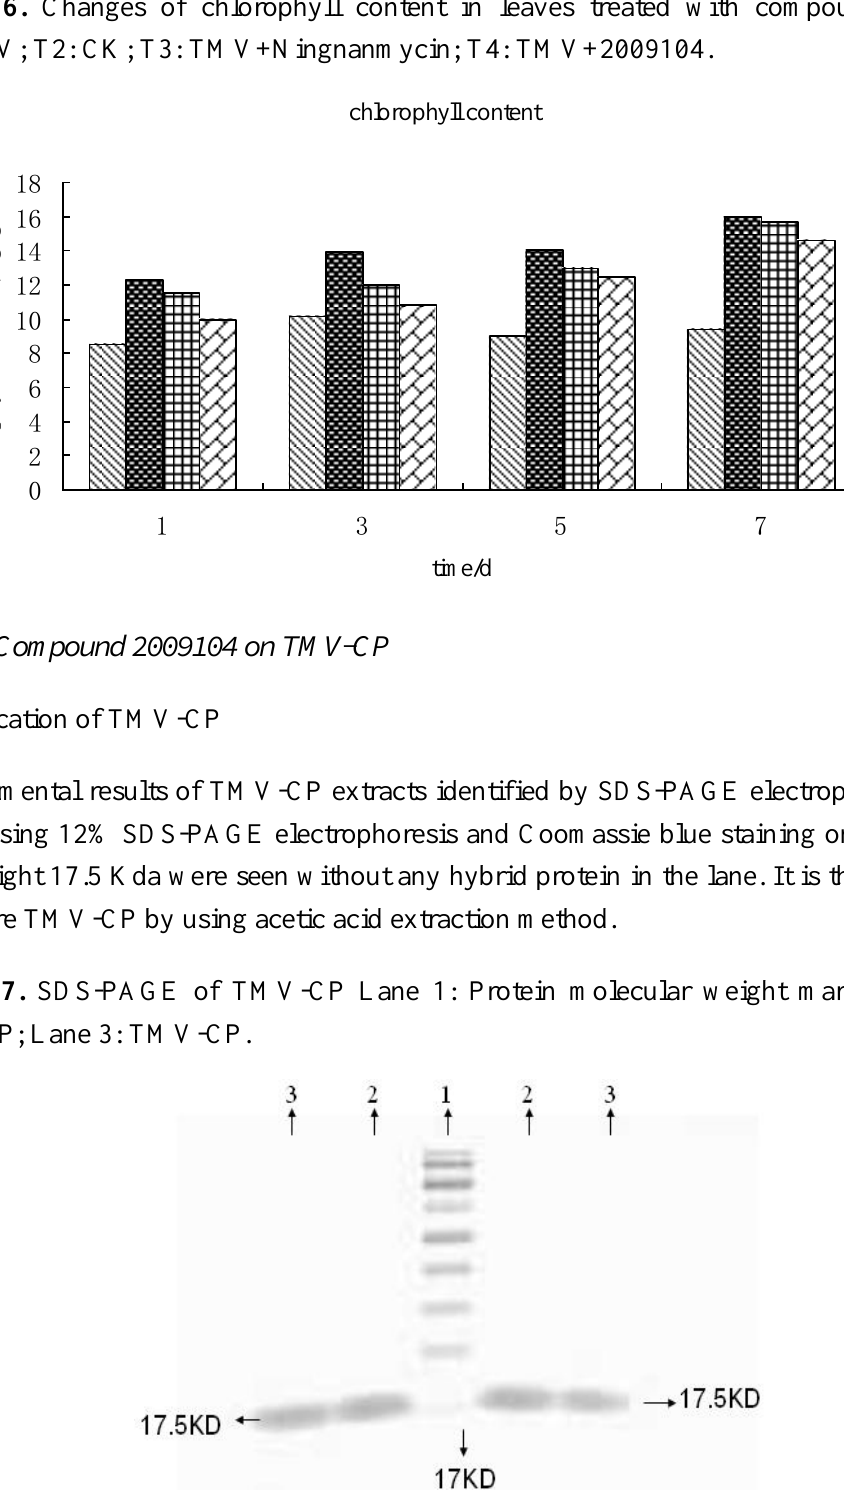
Figure 6. Changes of chlorophyll content in leaves treated with compound 2009104